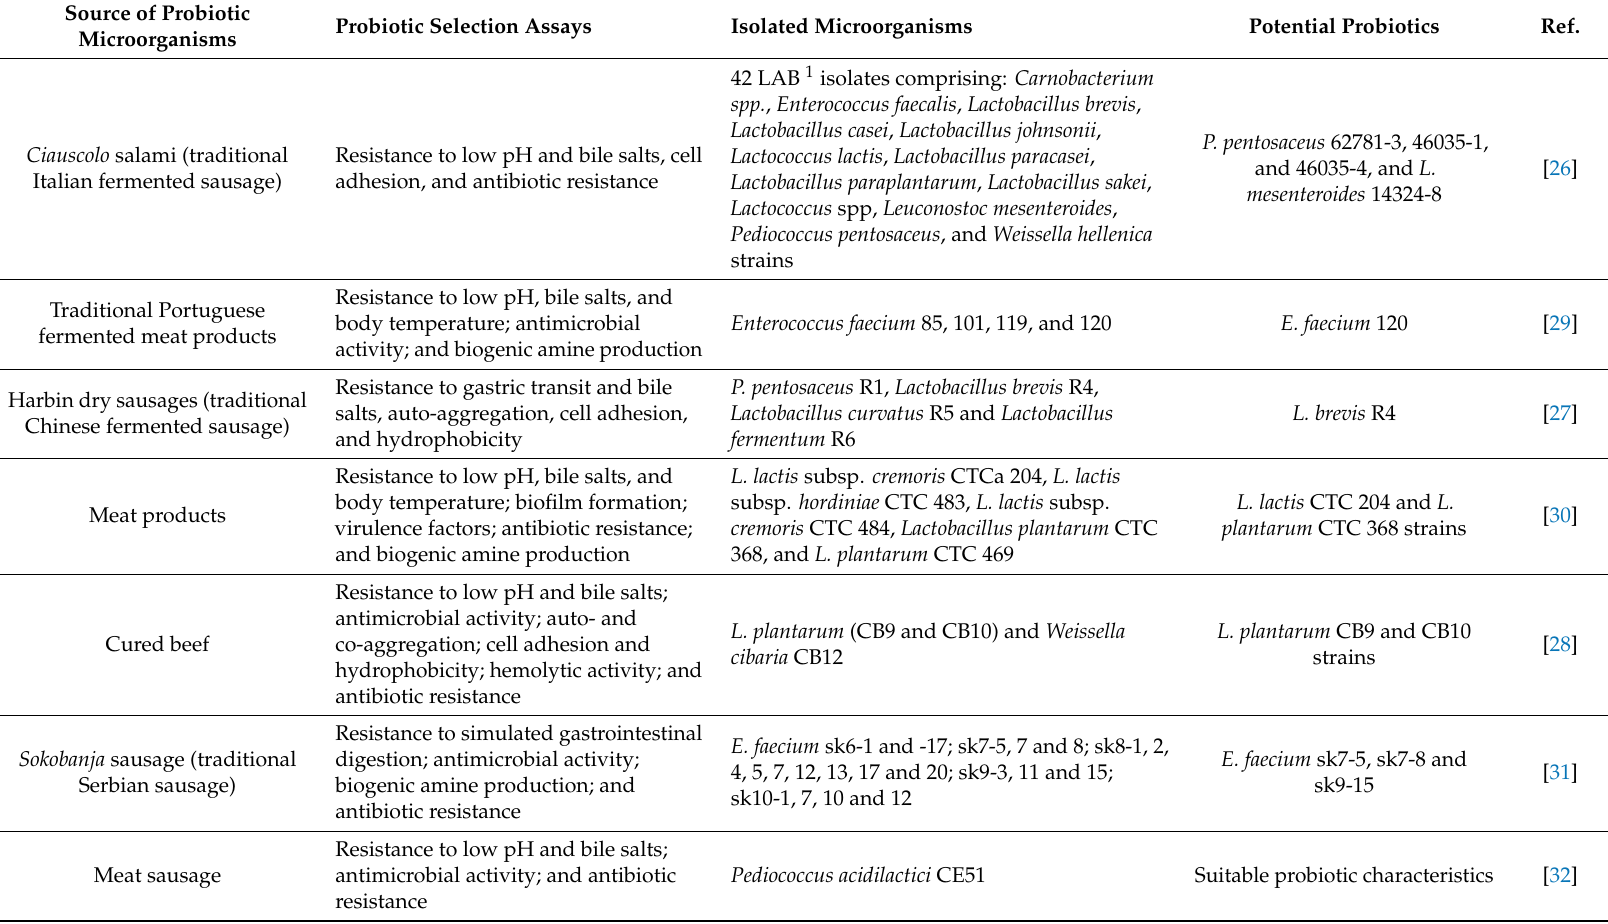
Table 1. Autochthonous probiotic strains found in meat